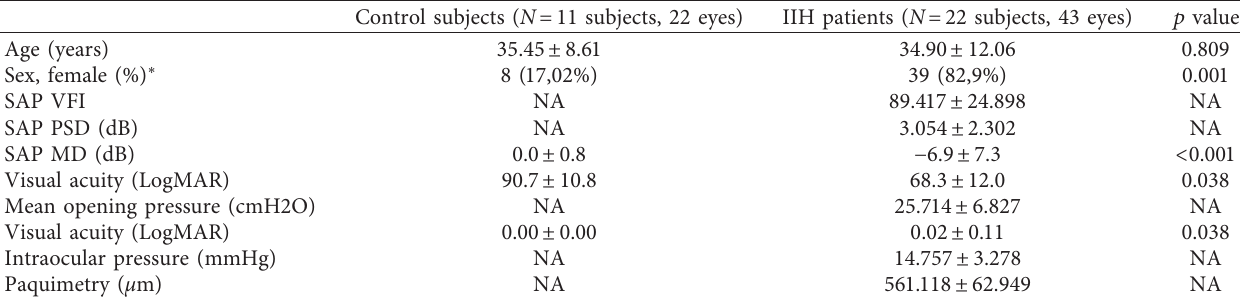
Table 1: Demographic and clinical characteristics of study patients (mean ± standard deviation).